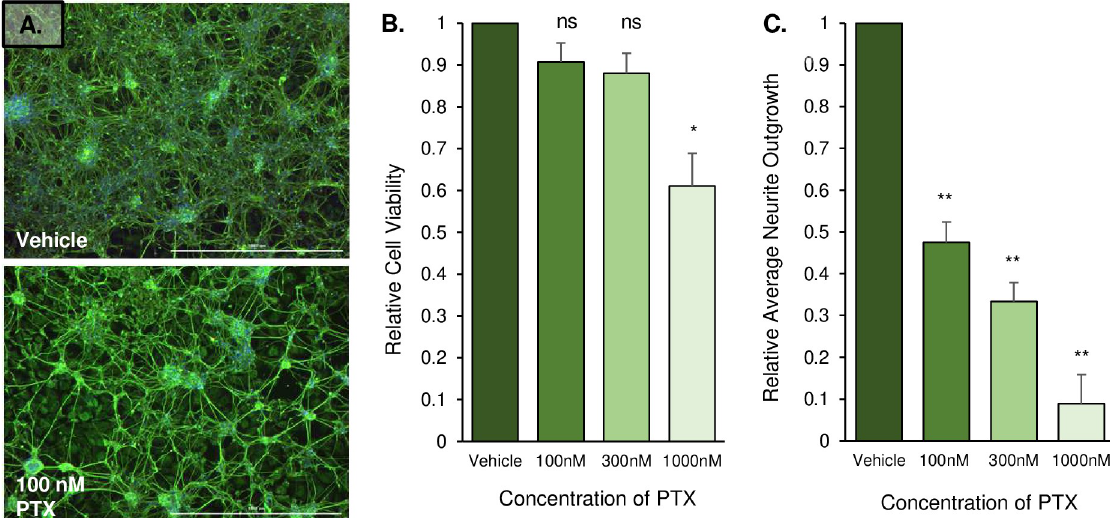
Fig 1. Paclitaxel decreases average neurite outgrowth but not viability of iPSC-dSN. A) Representative immunofluorescent images of iPSC-dSN treated with vehicle or 100 nM paclitaxel for 48 hours. Neurite outgrowths are stained by β III-tubulin (green) and cell nuclei are stained with Hoeschst 33342 dye (blue). Scale bars = 1000 μ m. B) Viability of paclitaxel-treated iPSC-dSN relative to vehicle treatment. C) Average neurite outgrowth of paclitaxel-treated iPSC-dSN relative to vehicle treatment. Each experiment was conducted with technical triplicates for each of the six cell lines. (PTX = paclitaxel, ns = non-significant, � = p < 0.05; �� = p < 0.01). Error bars represent standard error of the mean (SEM).